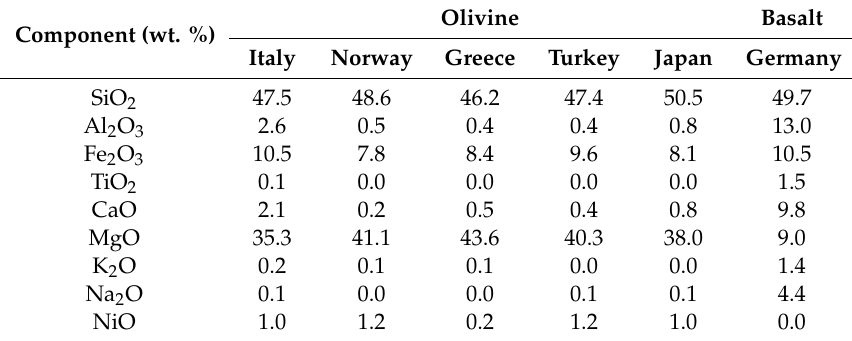
Table 1. Chemical composition of the examined mineral samples.